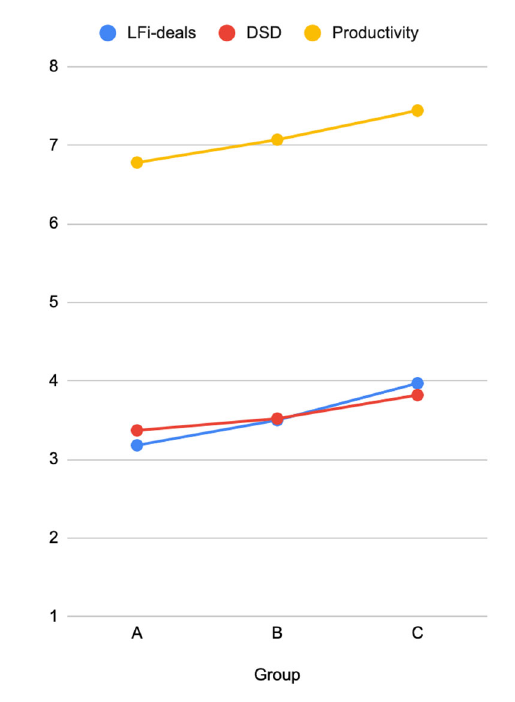
Figure 1. Mean of LFi-deals, DSD, and productivity for each